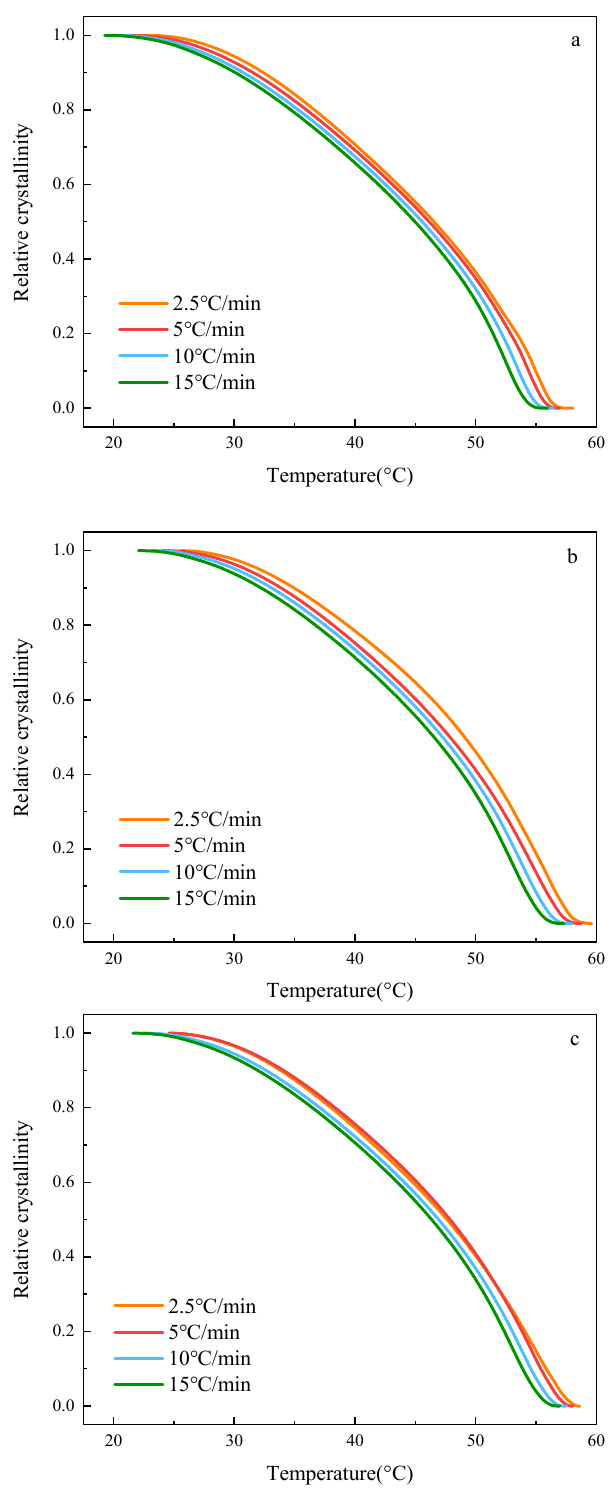
Figure 8. Relationship between the relative crystallinity and temperature at different cooling rate: ( a ) VGO4, ( b ) VGO4 + 100 ppm AMAC, and ( c ) VGO4 + 100 ppm EMAC. According to Formula (1), the plots of ln ϕ as a function of ln t are shown in Figure 9. The plots of the three samples are almost parallel straight lines, indicating that these two parameters had a good linear relationship. This work confirms that the equation proposed by Mo is suitable for studying the non-isothermal crystallization process of paraffin in VGO4. The intercept F ( t ) and the slope α were obtained from Figure 9, where F(t) can reflect the rate of the crystallization, and the larger the F ( t ) is, the smaller the crystalliza- tion rate. The parameters reported in Table 11 showed that, when the cooling rate was the same, the crystallization rate of paraffin in VGO4 with comb-type copolymers was higher than that in VGO4, indicating that the AMAC and EMAC comb-type copolymers pro- moted the crystallization process and increased the crystallization rate of paraffin, which led to the crystals more aggregated and the crystallite size big, and therefore, relatively complete morphologies of the crystals were observed. These modifications increased the filtration speed and enhanced the production efficiency of the MEK–toluene unit. -1.5 -1.0